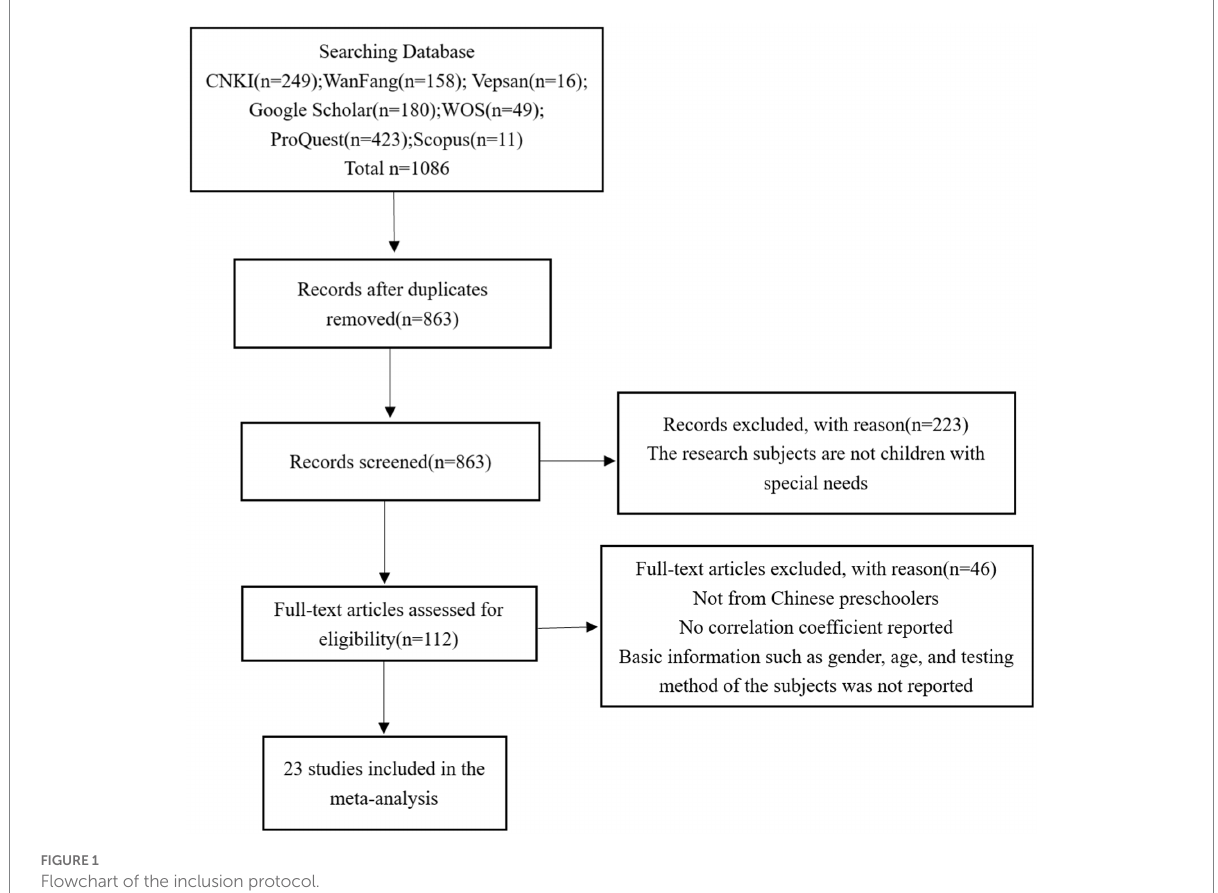
FIGURE 1 Flowchart of the inclusion protocol.